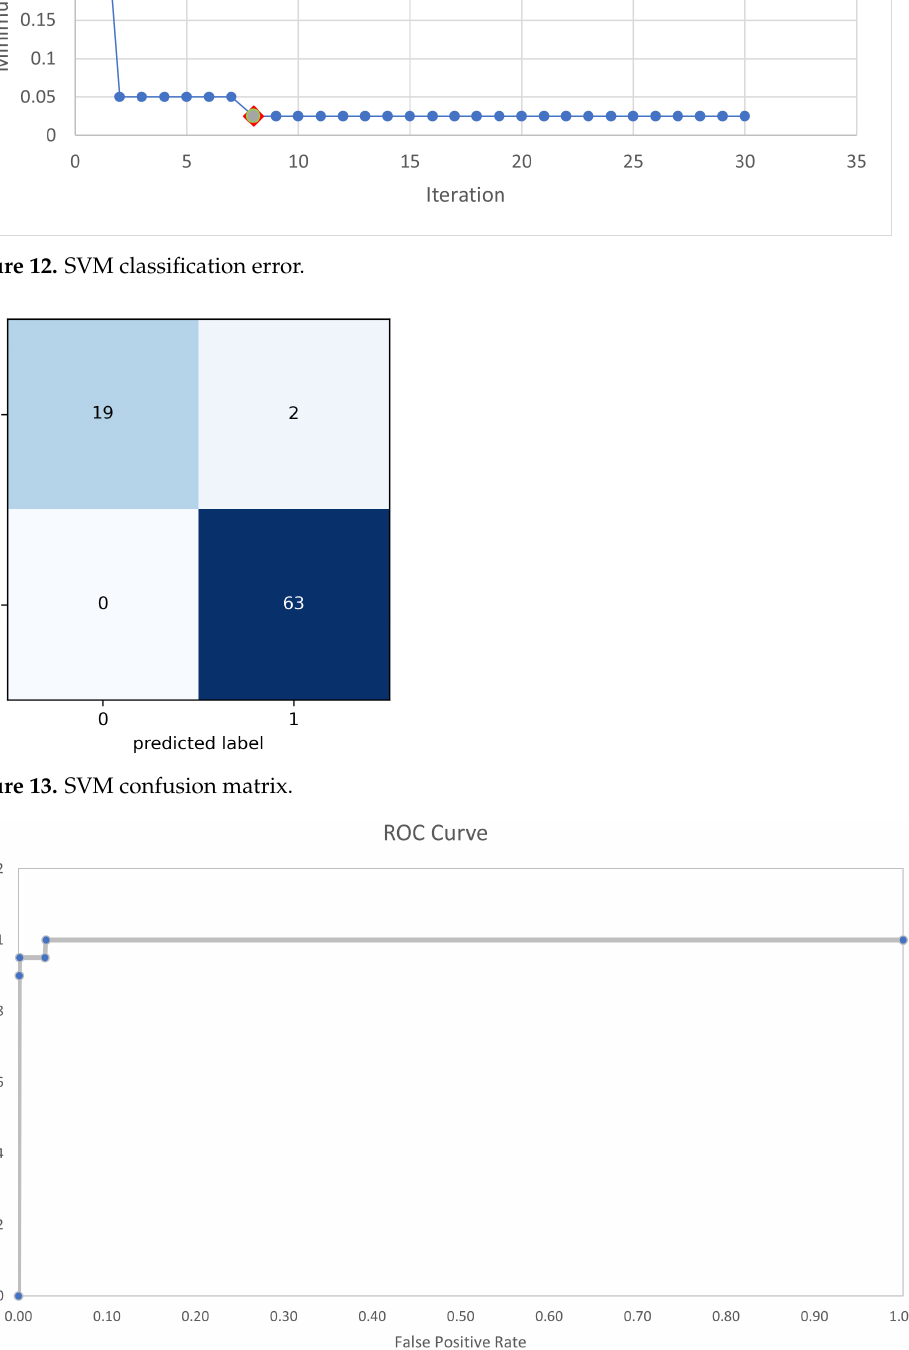
Figure 14. SVM ROC